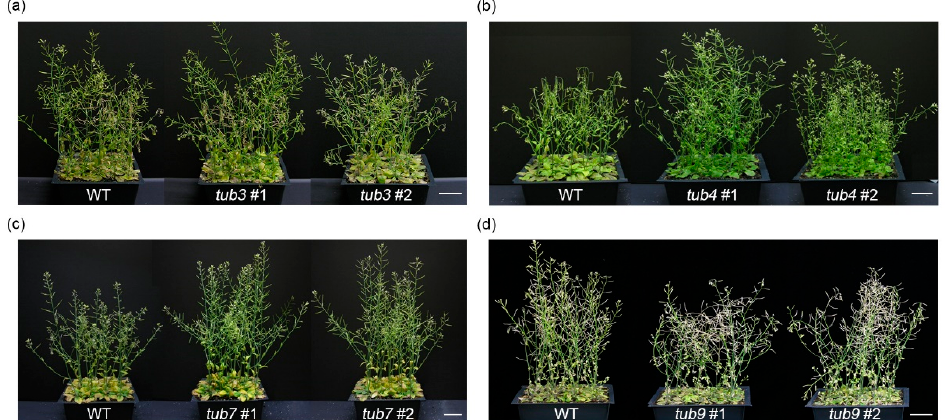
Figure 6. Characterization of loss-of-function mutants of Arabidopsis β -tubulin genes in salt stress. The 2-week-old wild-type (WT), tub3 ( a ), tub4 ( b ), tub7 ( c ), and tub9 ( d ) mutants grown on soil were treated with 130 mM NaCl for four weeks. Photos show a representative of 12 to 16 individual test plants. Scale bars indicate 5 cm.